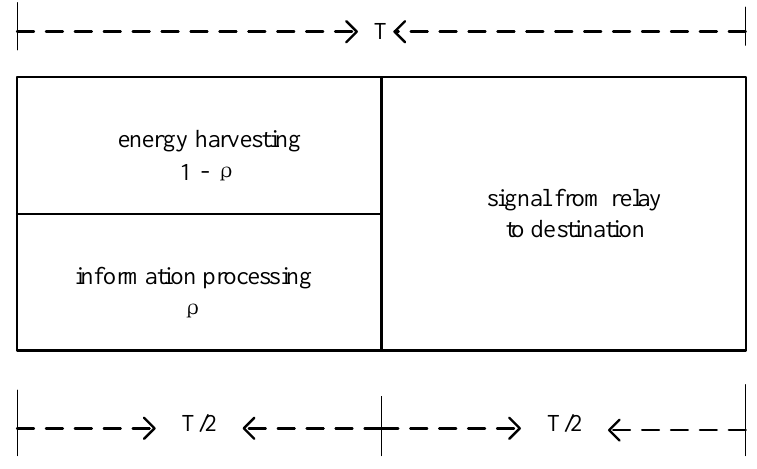
Figure 3. Half-duplex EH